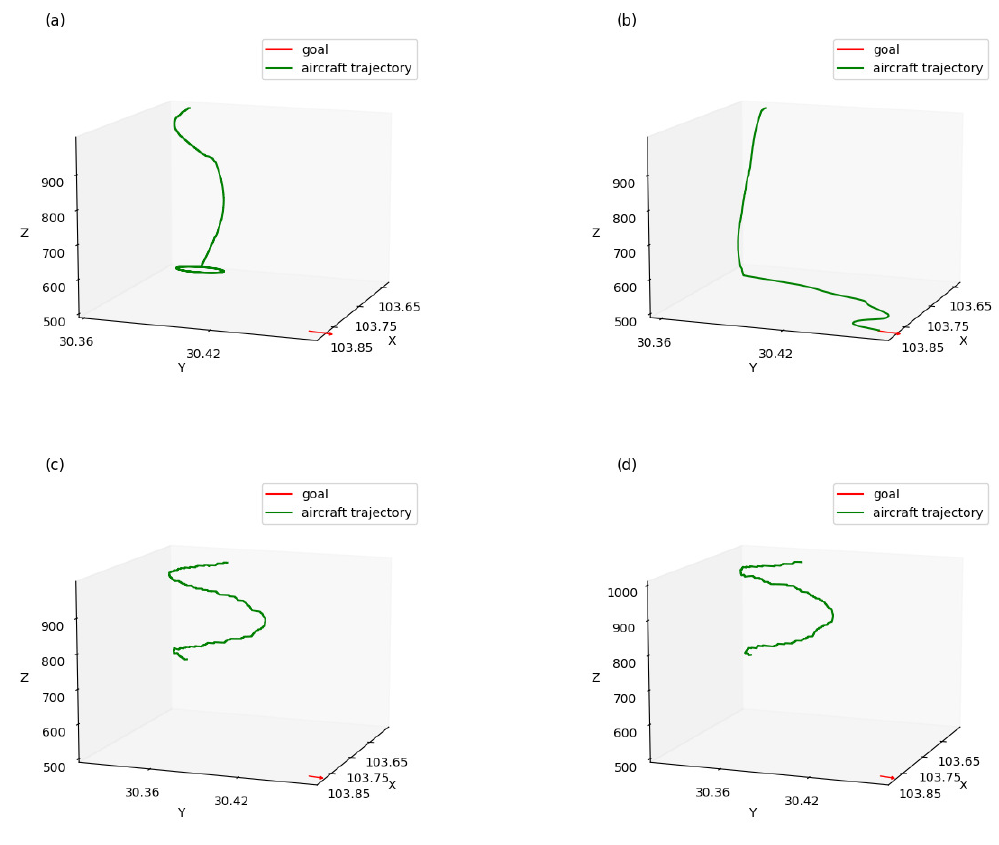
Figure 11. Trajectories of aircraft without considering arrival time: ( a ) multi-layer approach without reward shaping; ( b ) multi-layer approach with reward shaping; ( c ) not layered approach without reward shaping; and ( d ) not layered approach with reward